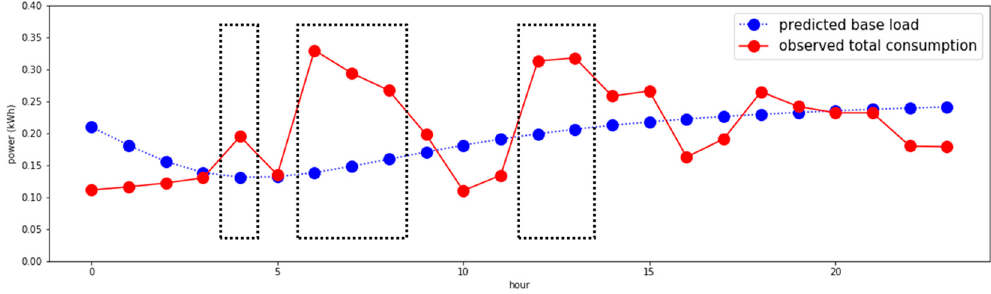
Figure 8. Finding actual positive cases.